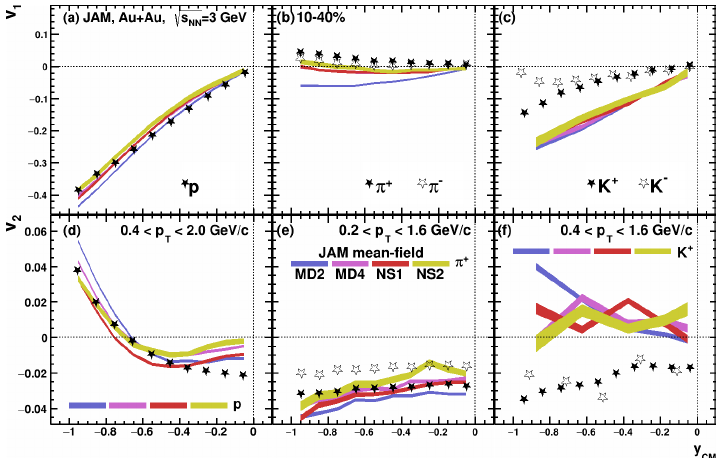
Figure 10. Rapidity ( y cm ) dependence of v 1 ( a – c ) and v 2 ( d – f ) of proton ( a , d ), charged pions ( b , e ) and √ s NN = 3.0 GeV. The symbols denote the charged kaons ( c , f ) in 10–40% central Au + Au collisions at published data from the STAR experiment [15]. The blue (MD2), purple (MD4), red (NS1) and yellow (NS2) bands represent the results from the mean-field mode of the JAM model with different EOS, as indicated. The uncertainties of the simulated model data are